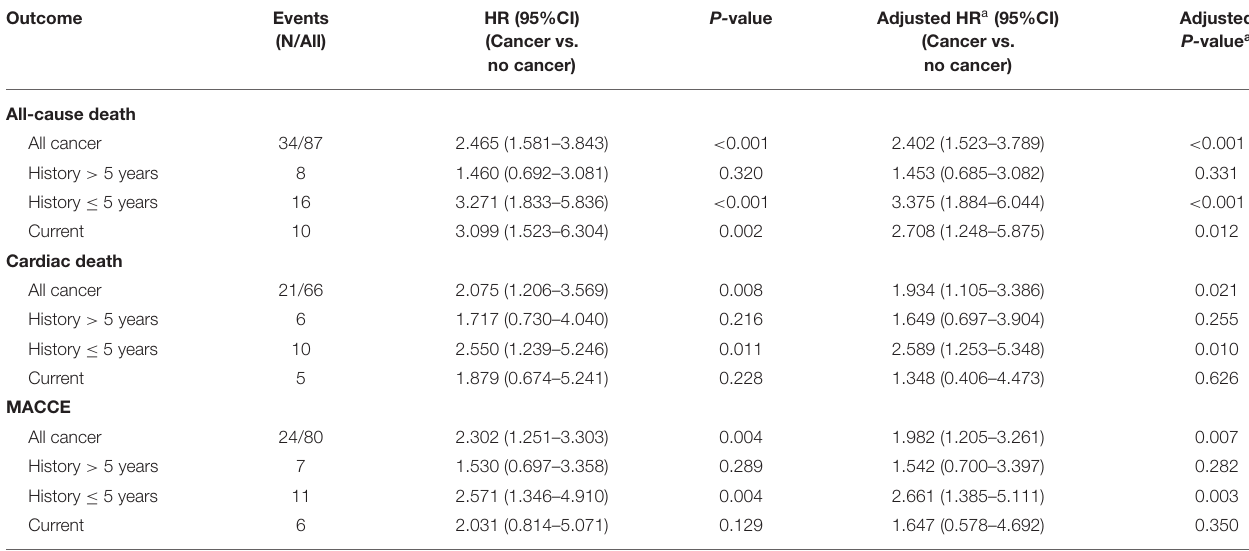
TABLE 2 | Outcomes according to the timing of the cancer diagnosis.